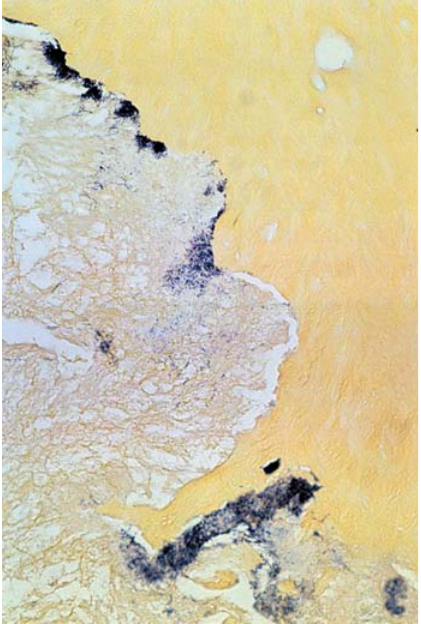
FIGURE 7- Microorganisms forming biofilms in the apical and periapical region, Brown & Brenn - 125X